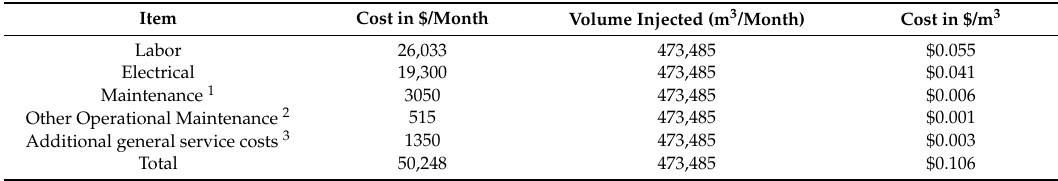
Table 2. Estimated Operating Costs of the MAR System (Injection Only) at the Kissimmee ASR Site